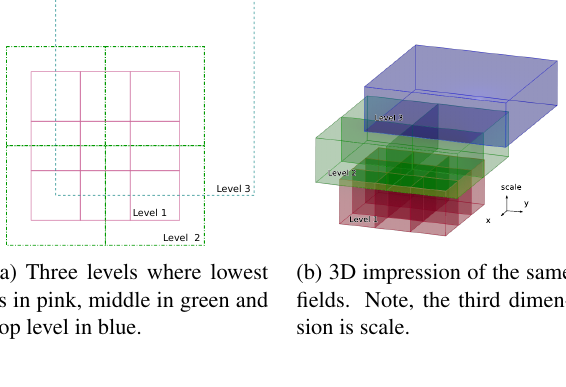
Figure 2: A Fieldtree (top view and 3D impression) signed for GIS and similar applications. Besides its multi-level organization of space, it subdivides space regularly, spatial ob- jects are never fragmented, and geometric and semantic informa- tion can be used to assign the location of a certain object in the Fieldtree.